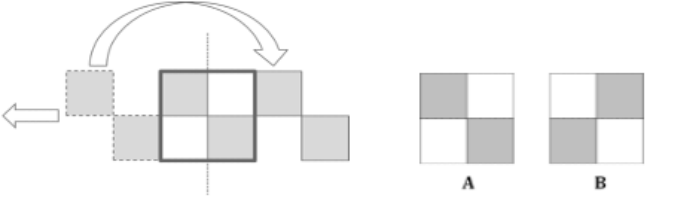
Figure 2. Switching of binary opposing states—pixel (shaded square) and void (blank square)— by alternating image A and B. [1]. Pixels denote manifested metaconsciousness, voids denote unmanifested metaconsciousness.